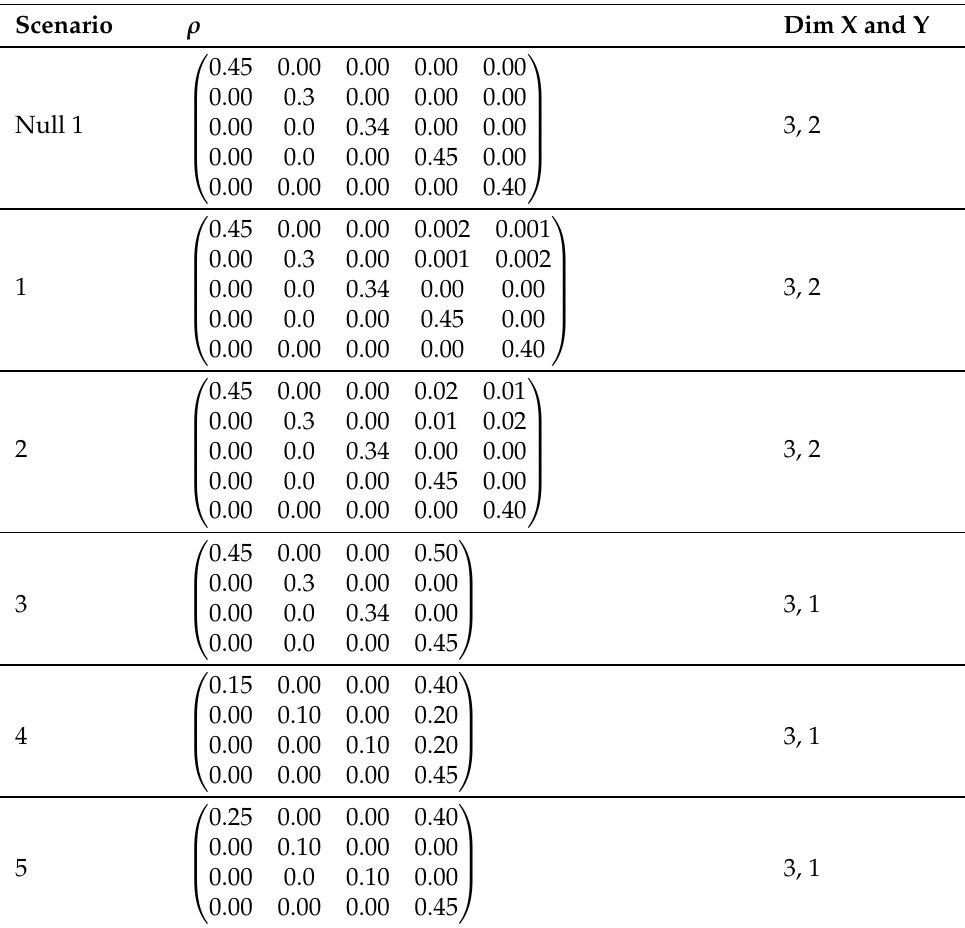
Table 1. Six scenario for the simulations of ρ